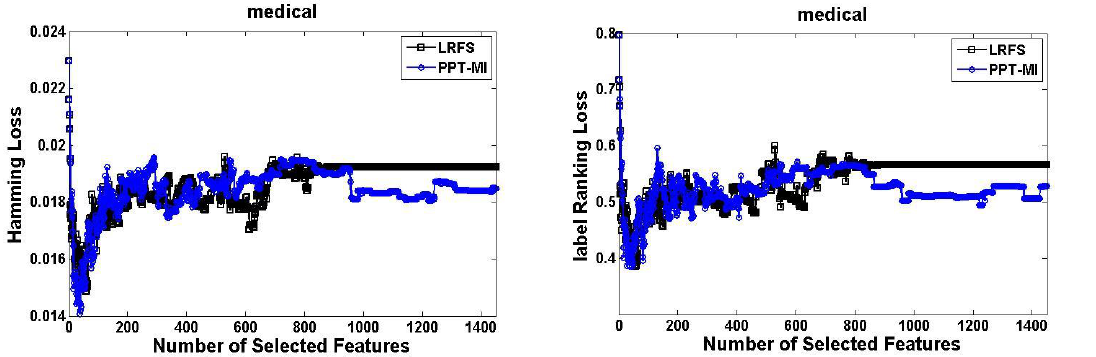
Fig. 3. The results on medical dataset (left) hamming loss, (right) label ranking loss. The running times to rank all the features using LRFS and PPT-MI are 10778 and 92 seconds,